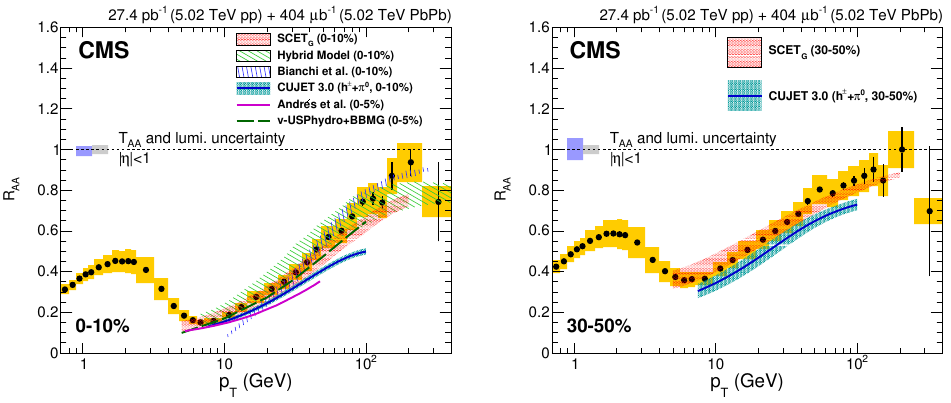
Figure 4 . Charged-particle R AA measured in the 0{10% (left) and 30{50% (right) centrality p ranges at s NN = 5 : 02 TeV compared to predictions of models from refs. [38{43]. The yellow band represents the systematic uncertainty of the 5.02 TeV CMS